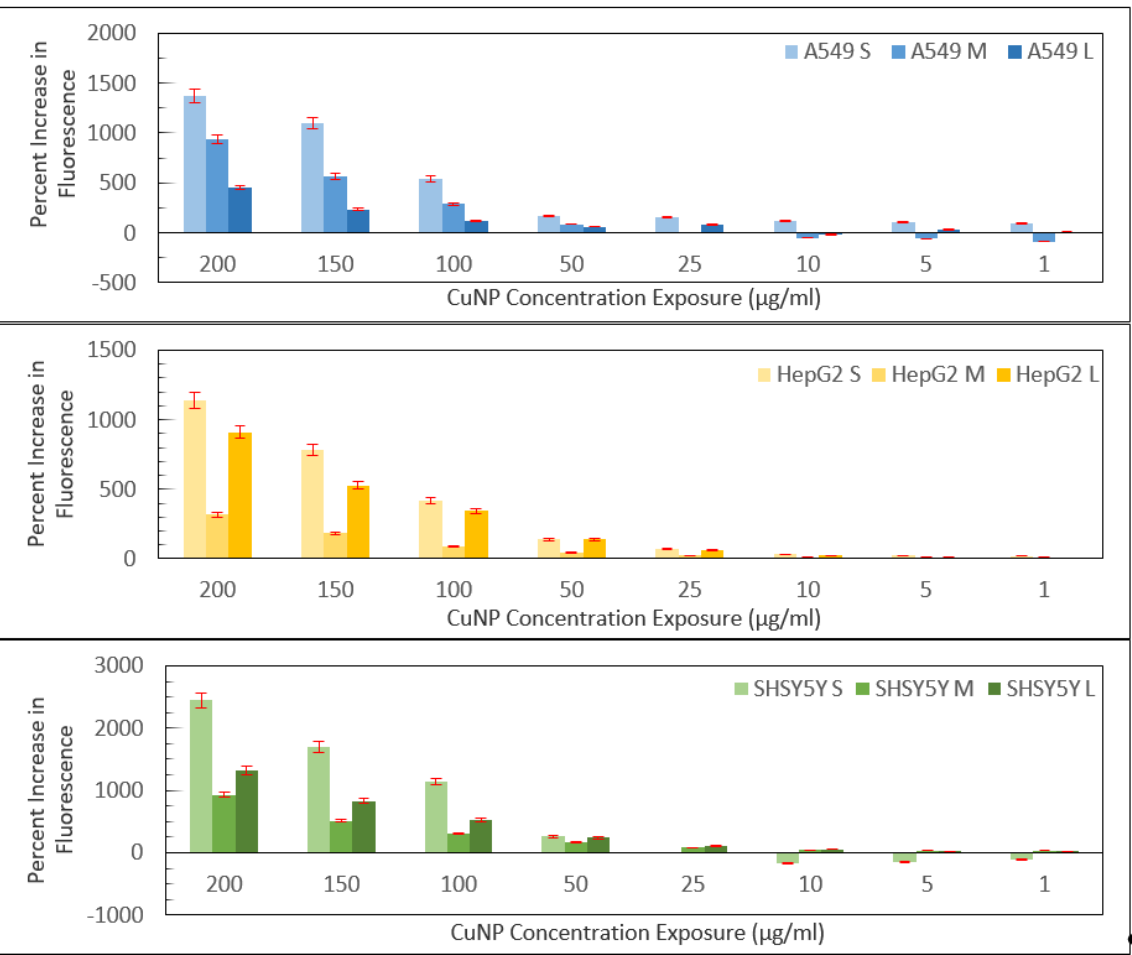
Figure 6. DCFDA results measured for all three nanoparticle sizes in three different cell lines across eight concentrations. Percent increase calculated by calculating the percent increase of fluorescence relative to 0 µ g/mL on a plate at 0 h (right after applying the dilution) and after 1 h of incubation and then subtracting the percent increase at 1 h and 0